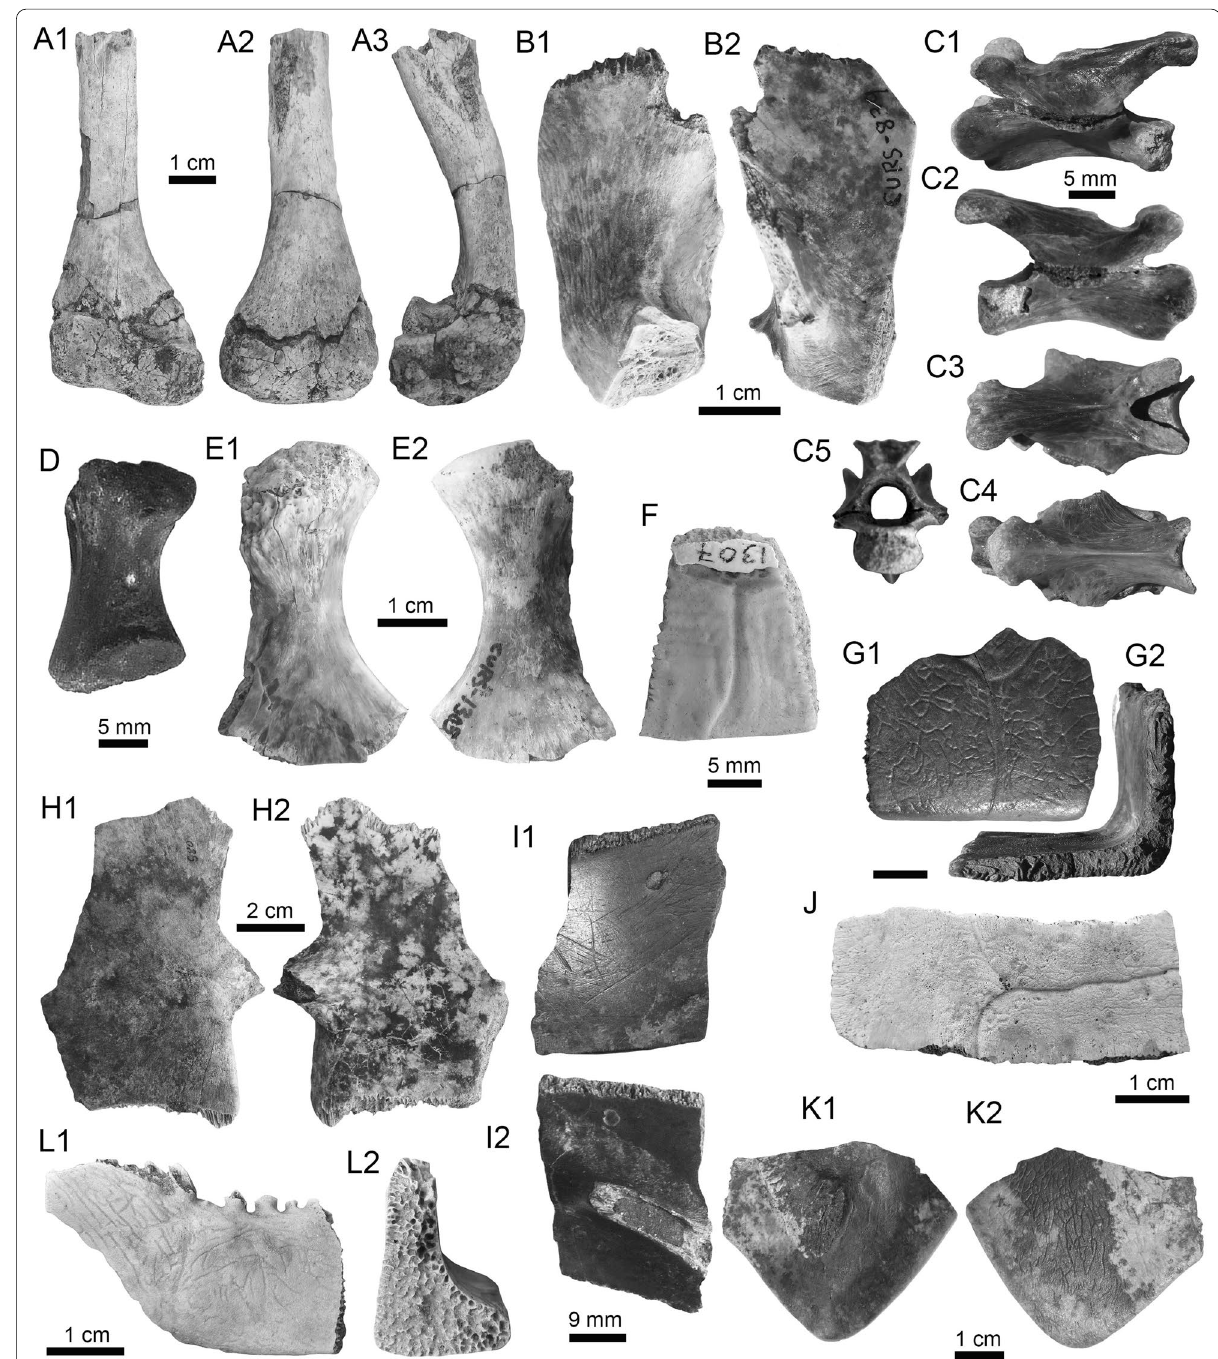
Fig. 15 Testudines (Testudinidae, Chelidae, and Podocnemididae) from the Vergel ( A1 – D , G1 – I2 , K1 – L2 ) and Cocuiza ( E1 – F , J ) members. A1 – A3 Incomplete right femur of Chelonoidis sp. (AMU‑CURS‑584). B1 , B2 Anterolateral portion of a left xiphiplastron of Chelus sp. (AMU‑CURS‑839). C1 – K2 Podocnemididae indet. C1 – C5 Cervical vertebra (AMU‑CURS‑571). D Left ilium (AMU‑CURS‑675). E1 , E2 Left ischium (AMU‑CURS‑1305). F Peripheral bone from the posterior margin of the carapace (AMU‑CURS‑1307). G Peripheral bone from the bridge region of the shell (AMU‑CURS‑838). H1 , H2 Partial right hypoplastron (AMU‑CURS‑580). I1 , I2 Lateral portion of a costal bone, potentially left costal 5 (AMU‑CURS‑547). J Costal bone potentially the right costal 6 (AMU‑CURS‑1306). K1 , K2 Posterior tip of a right xiphiplastron (AMU‑CURS‑79). L1 , L2 Peripheral bone from the carapace‑plastron bridge region (AMU‑CURS‑579). Views: anterior ( A2 ), dorsal ( C3 , E1 , F ), cross ‐ sectional ( G2 , L2 ), internal ( B1 , H2 , I2 , K1 ), external ( B2 , H1 , I1 , J , K2 , L1 ), left lateral ( C1 ), right lateral ( A3 , C2 ), lateral ( D , G1 ), posterior ( A1 , C5 ), and ventral ( C4 , E2